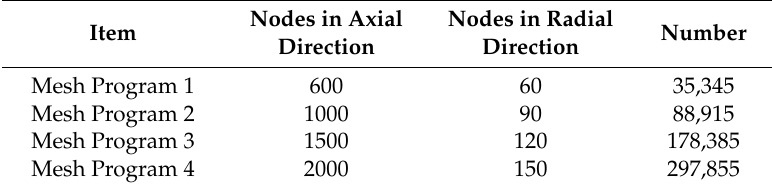
Table 1. Analysis for the independence of the